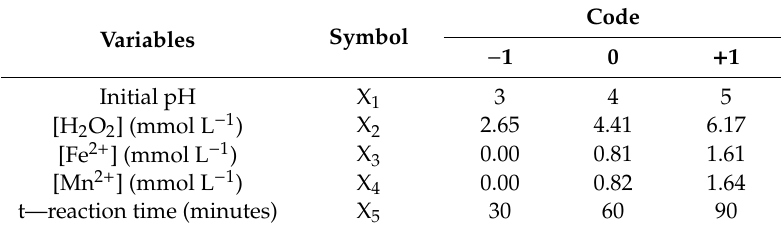
Table 1. Experimental design used for sulfamethoxazole (SMX) and trimethoprim (TMP) degradation